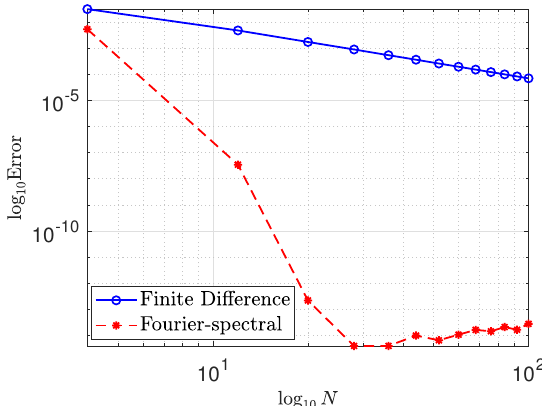
Figure 1. Convergence of second-order finite difference and Fourier-spectral method where u ( x ) = log ( 10 + cos x ) . Note that both axes are on log-scale.